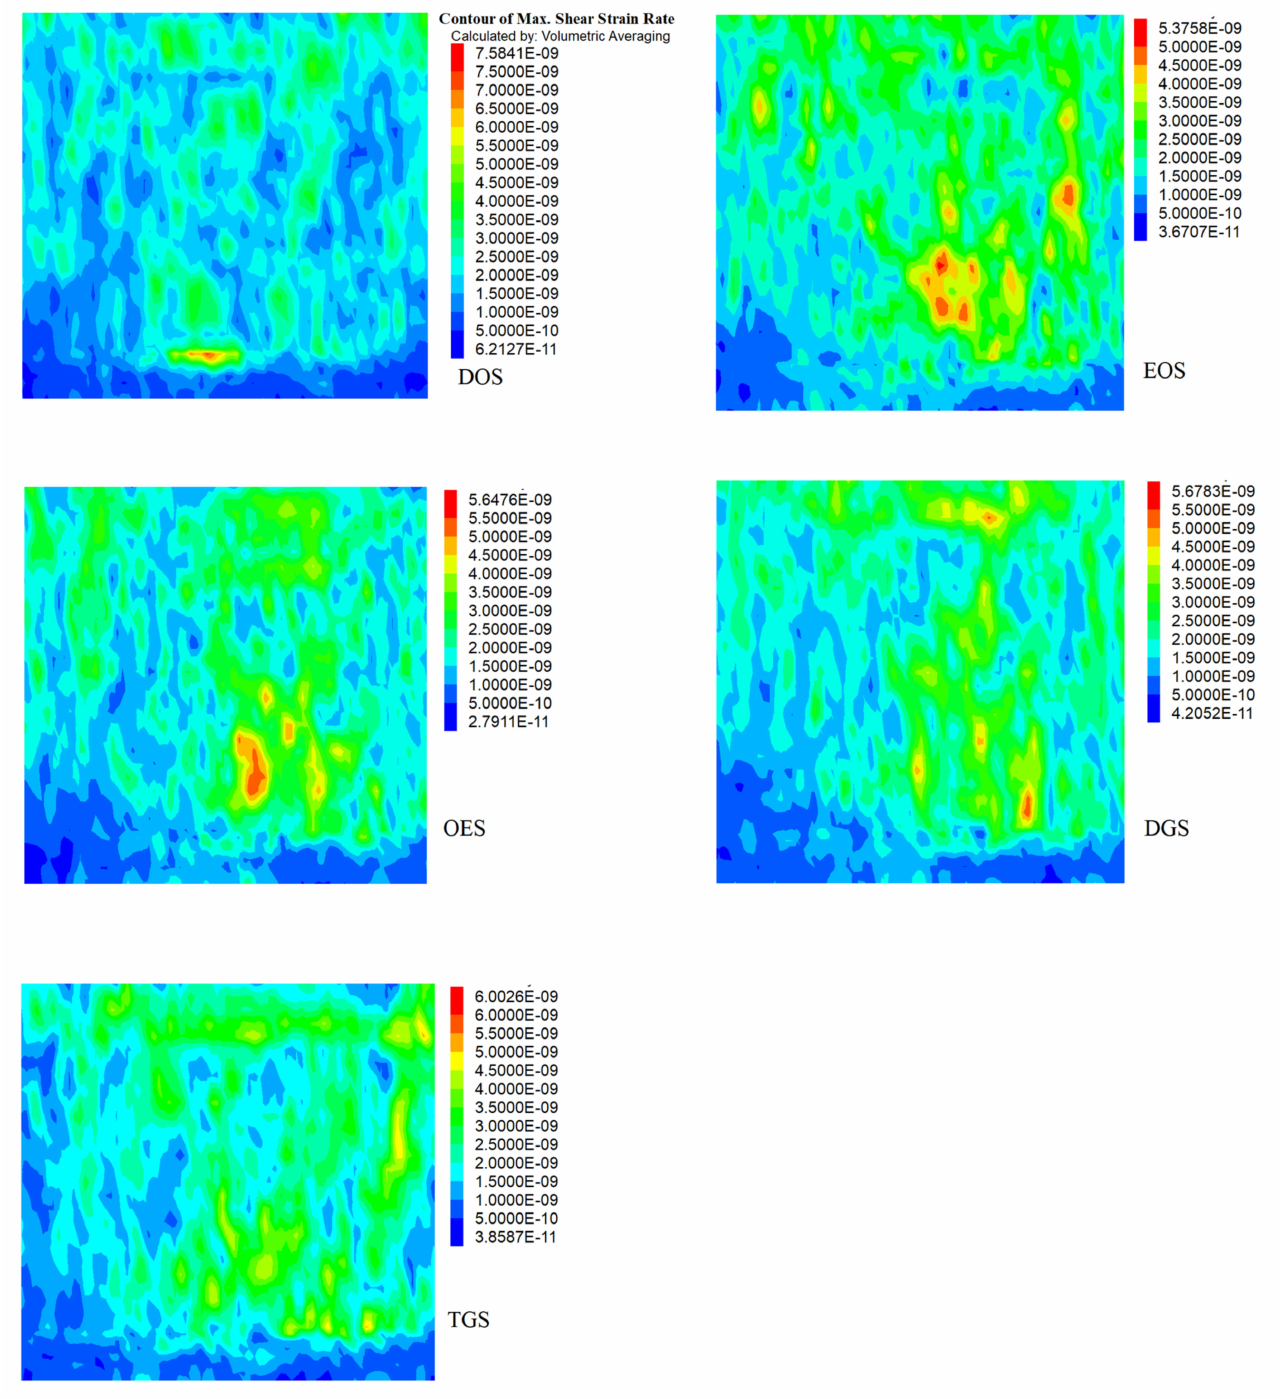
Figure 11. Contours of maximum shear strain rates. The numerical simulation shows that ground displacement for a particular panel excavation will not continuously increase throughout the excavation operation, but peak at some point when the backfill bodies become active in bearing the overlying load and the ground displacement will start to reduce and